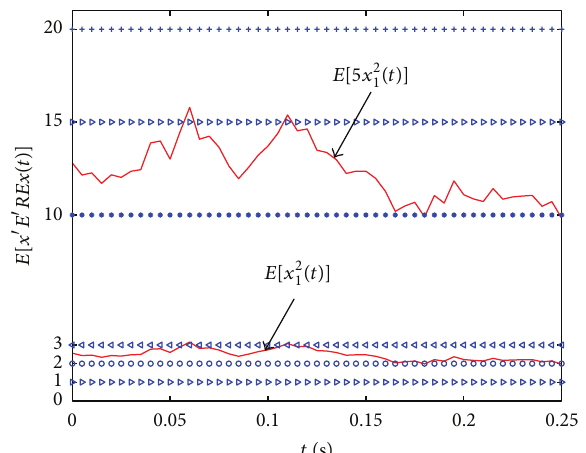
Figure 3: The evolution of E [𝑥 𝑇 (𝑡)𝐸 𝑇 𝑅𝐸𝑥(𝑡)] of system (1).